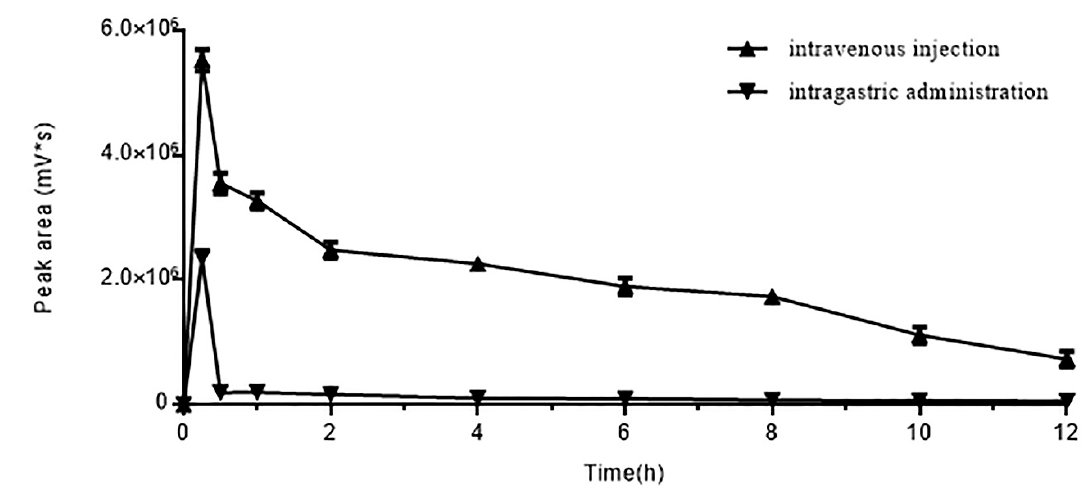
Figure 4. Effect of two administration methods on DhHP-6 absorption. Rats were given the same dose of DhHP-6 by intravenous injection/intragastric administration. The blood was collected at scheduled time and analyzed by HPLC. All results presented are means ± SD, n = 5.